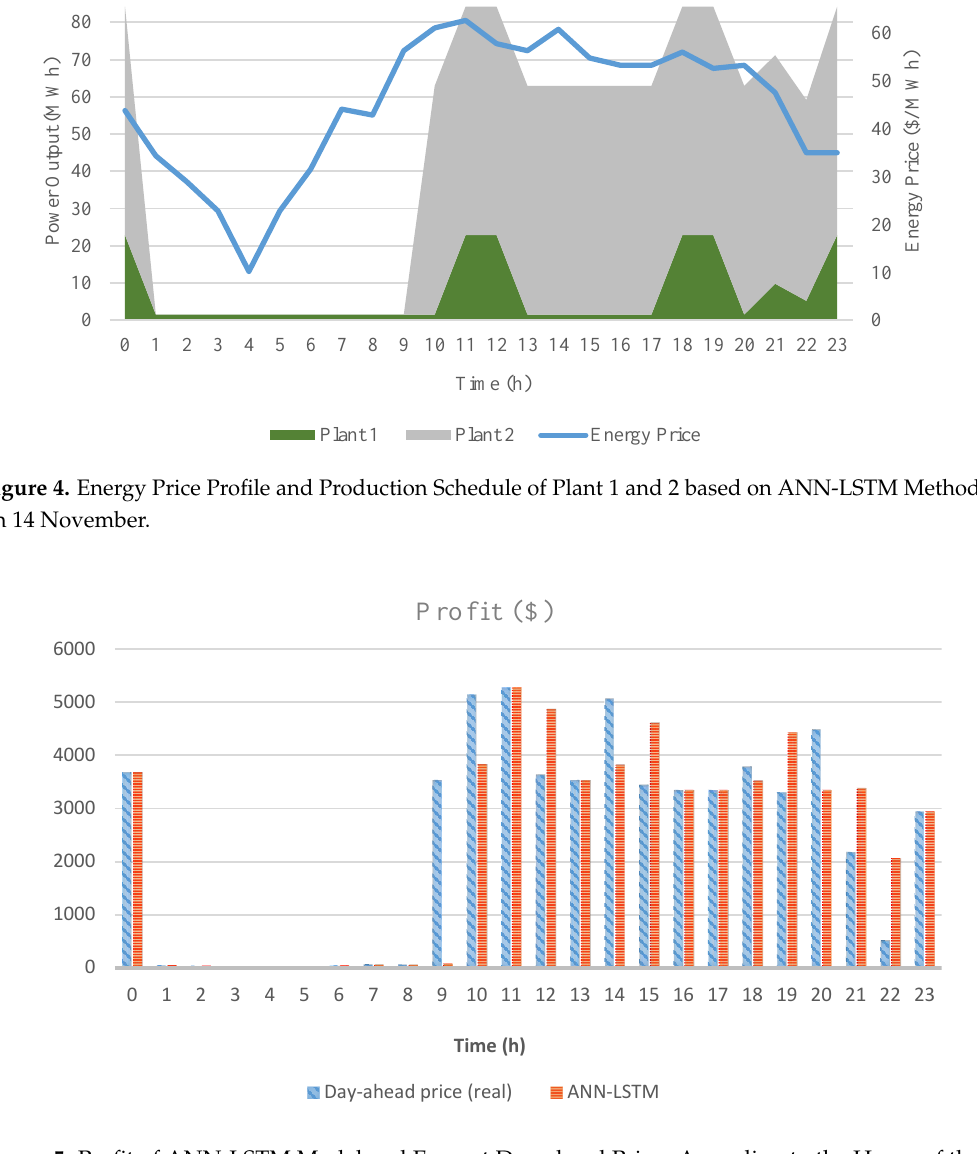
Figure 5. Profit of ANN-LSTM Model and Ex-post Day-ahead Prices According to the Hours of the Day on 14